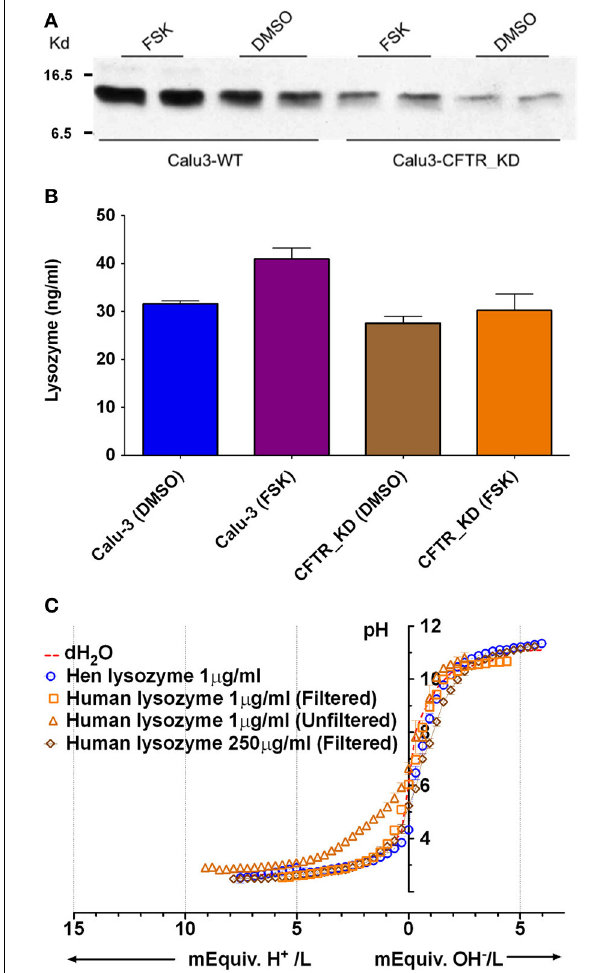
FIGURE 6 | Lysozyme expression and buffer capacity in pure solutions. (A) Immunoblot probed with anti-lysozyme antibody in duplicate samples from control Calu-3 and Calu-3 CFTR KD secretions under basal conditions and during forskolin stimulation. (B) Quantitation of lysozyme by ELISA under each condition shown in (A) . Data are means ± SD; n = 3 . (C) Titration curves for lysozyme solutions ( n = 4 ). Dotted line also shows